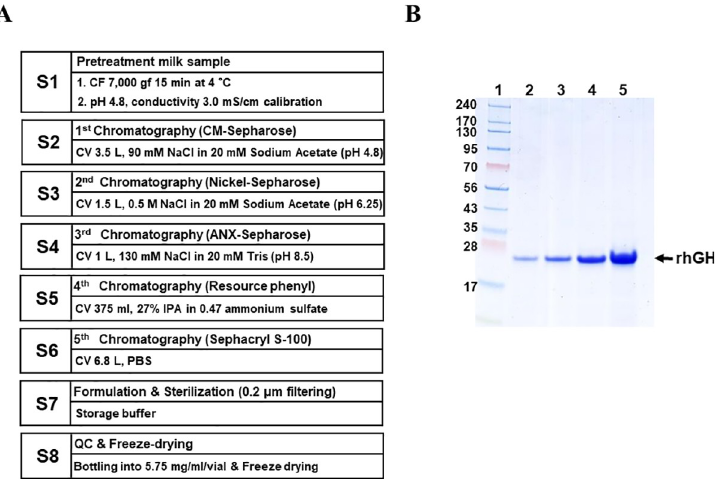
Fig 3. Preclinical sample preparation by column purification. (A) 5-step chromatography and freeze-drying procedure. S1–S8: Step 1 to Step 8 (B) Final purified rhGH was separated using a 5–12% EzWay gel and visualized by CBB staining. 1- Size marker, 2–1 μ g, 3–2 μ g, 4–5 μ g, 5–10 μ